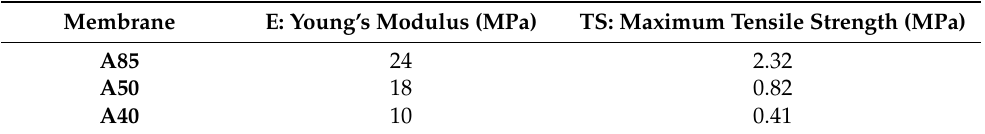
Table 2. Measurements of mechanical resistance.